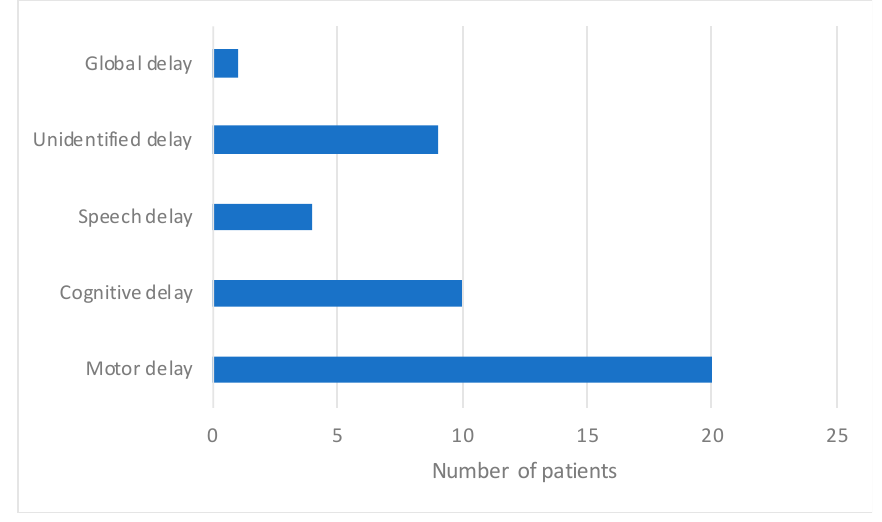
Figure 5. Distribution of reported developmental delay in NPC1 patients.